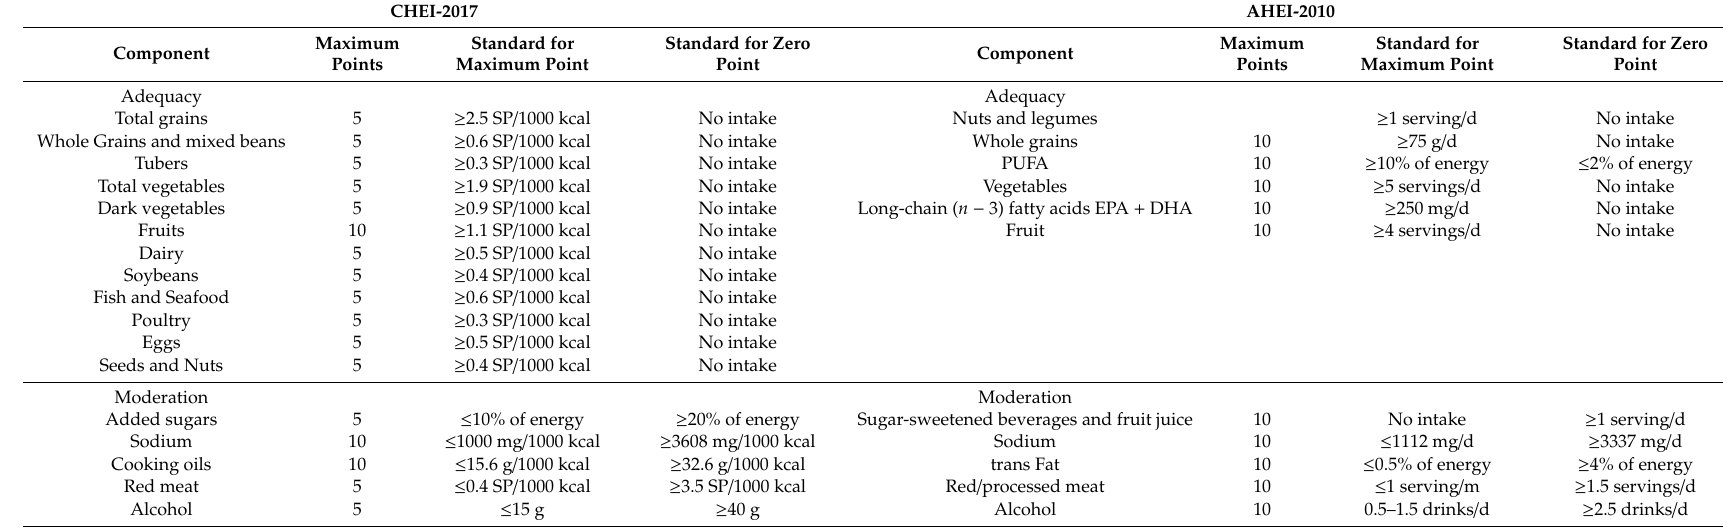
Table A1. Components and scoring mechanism of the Chinese Healthy Eating Index (CHEI) and the Alternate Healthy Eating Index